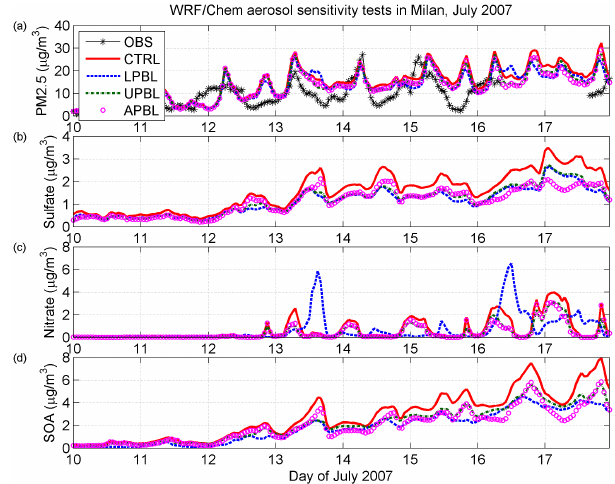
Figure 13. Sensitivity tests on chemical production in different ver- tical layers (see Table 2 for explanation of labels) at ground level over Milan on 10–17 July 2007. Hourly observations (black line) are only available for PM 2 . 5 (top